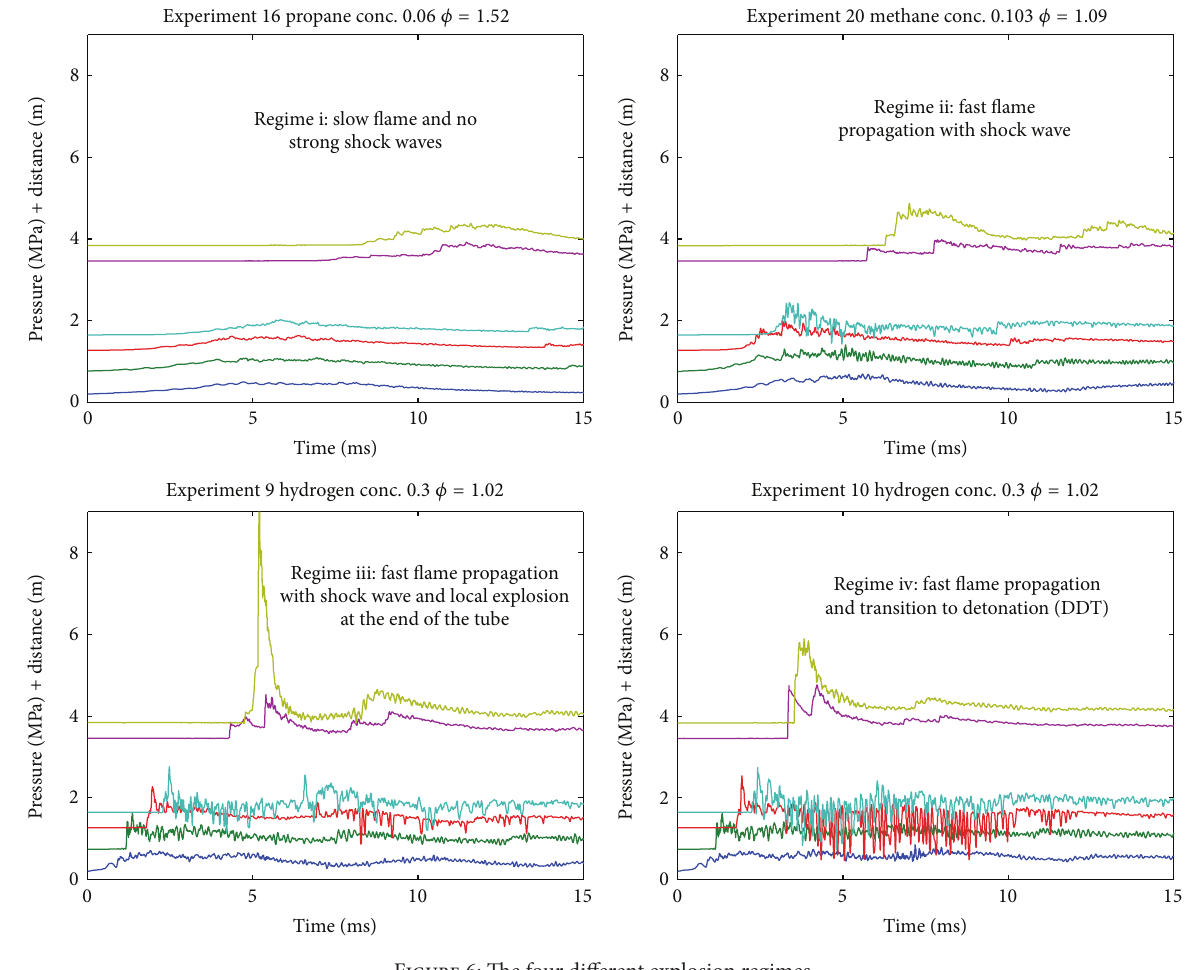
Figure 6: The four different explosion regimes.